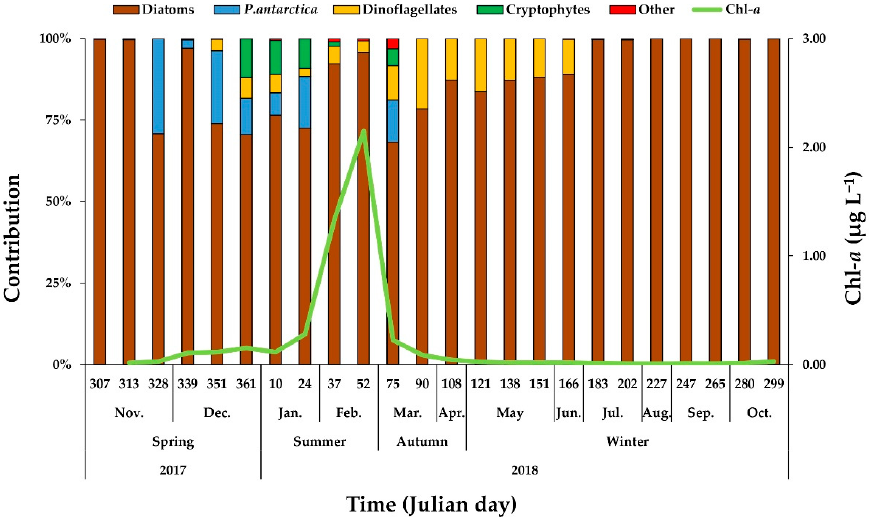
Figure 6. Contribution of phytoplankton communities at the JBS during our sampling period.